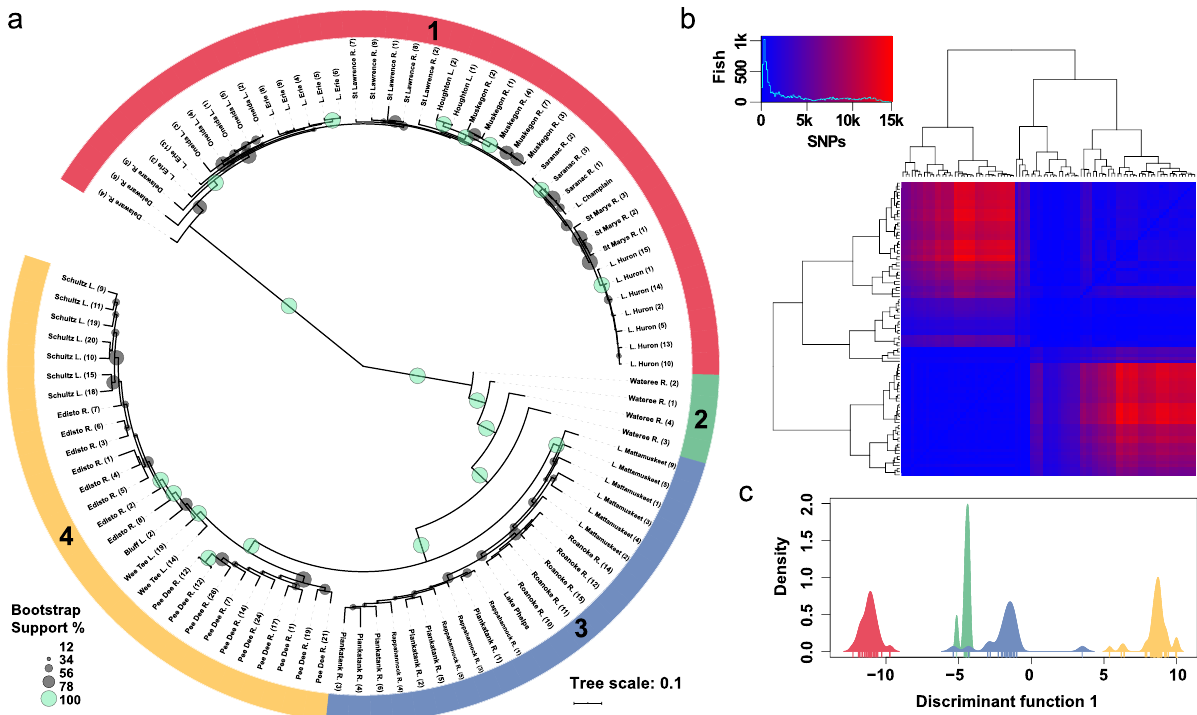
Figure 2. ( a ) Phylogenetic population structure of sampled Bowfin ( Amia spp.) based on 21,145 SNPs. Branches with 100% bootstrap support are colored in green and population genomic analysis carried out with hierBAPS detected 4 primary population clusters, demarcated with the colored, numbered rings (for rectangular phylogram, see Supplementary Fig. 2). ( b ) Heatmap depicting pairwise SNP differences, histogram and color key indicate distribution of SNPs across samples. ( c ) DAPC analysis results based on discriminant function 1, density plot is colored according to population designation in ( a